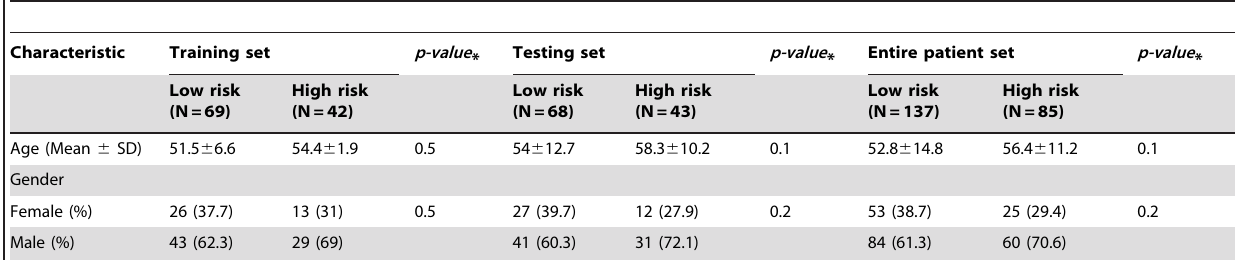
Table 1. Clinical characteristics of GBM patients according to their low or high risk group in the training set, the testing set and the entire patient set.